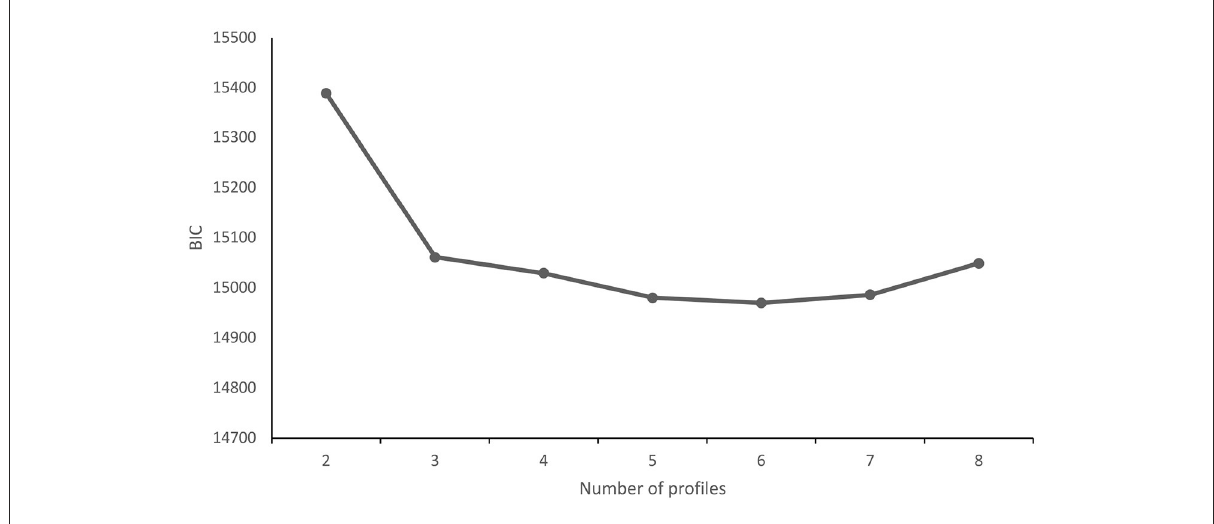
FIGURE1 Goodness of fit of the BIC. The y-axis represents BIC (Bayesian information criterion); the x-axis represents the number of profiles (starting from